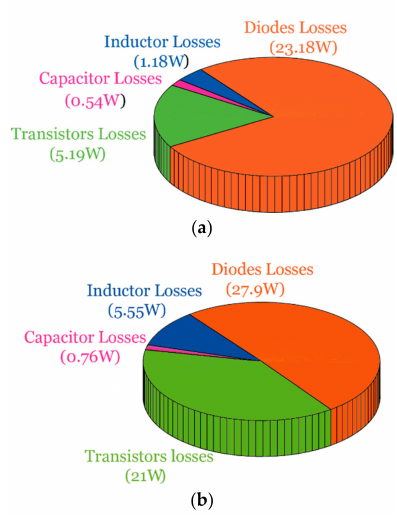
Figure 10. Calculated loss distributions for the experiment ( a ) When V in = 200 V, D = 0.3, and R L = 120 Ω . ( b ) When V in = 100 V, D = 0.7, and R L = 120 Ω